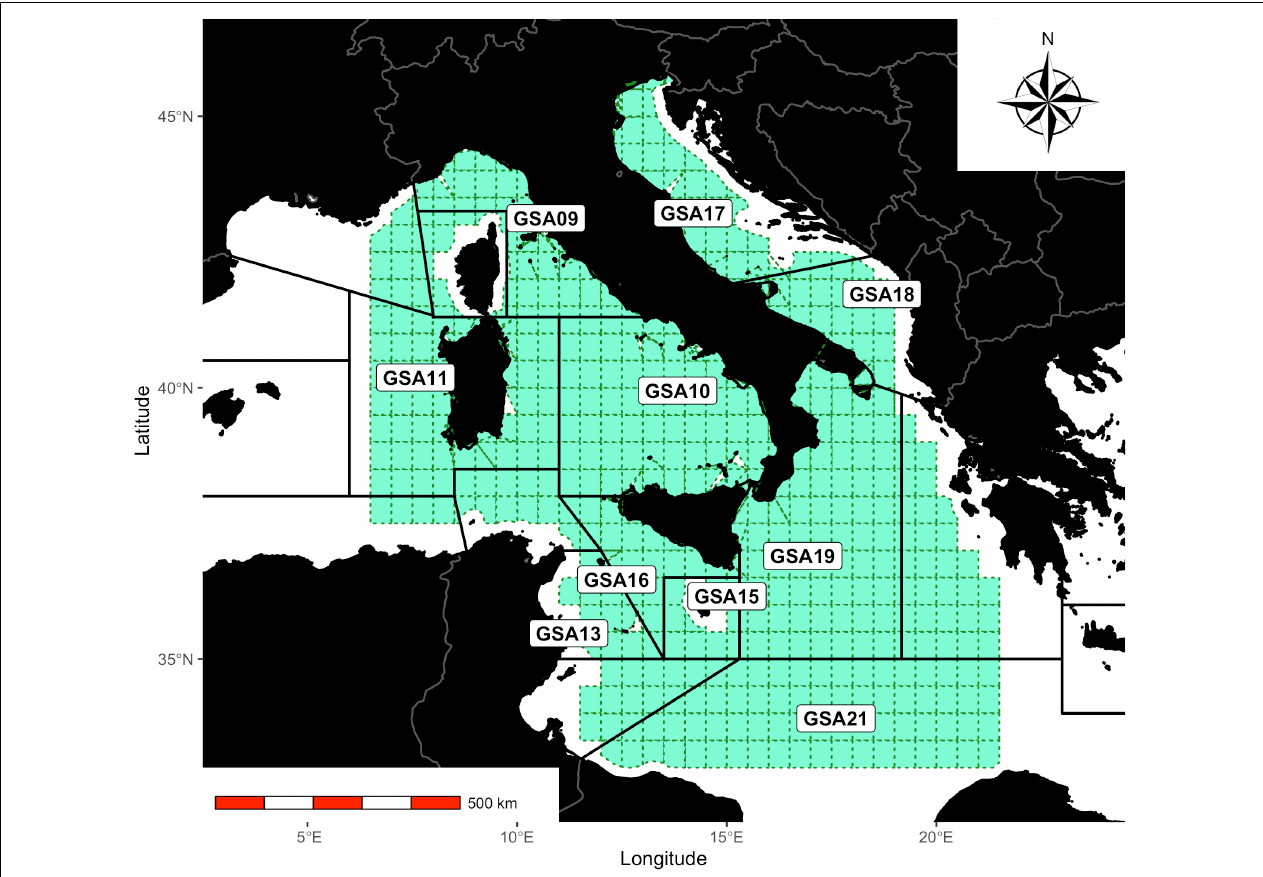
FIGURE 1 | Spatial domain of the study and 30 × 30 nautical miles grid established by the GFCM (). The Geographical Sub Areas (GSA) of the Mediterranean Sea considered in this study are also